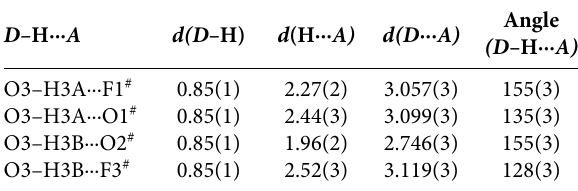
Table 3 . Hydrogen bond distances (Å) and bond angles (º) for com- plex 1